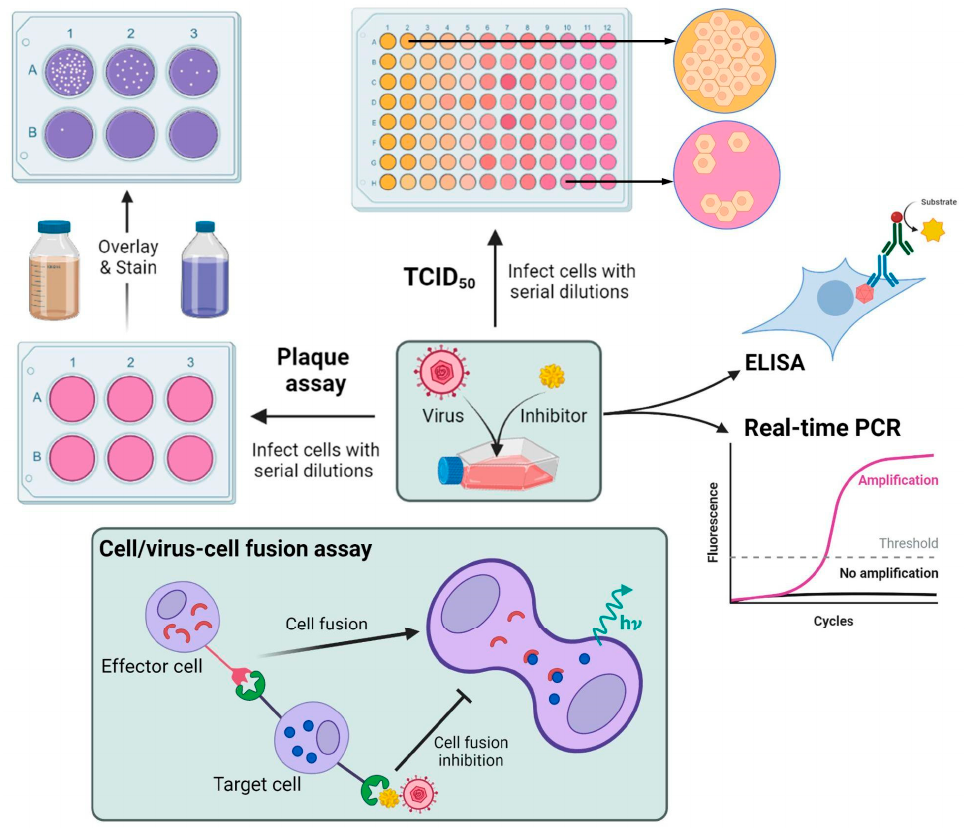
Figure 5. Common cell-based in vitro assays for direct and indirect antiviral activity determination of natural molecules. TCID50: 50% tissue culture infectious dose assay; ELISA: enzyme-linked immunosorbent assay; PCR: real-time polymerase chain reaction; h ν : emitted energy (fluorescence, luminescence).